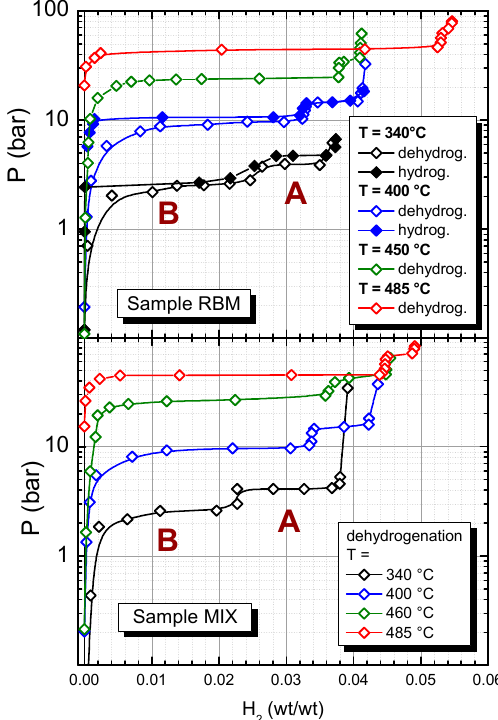
Figure 1. Pressure-composition isotherms of Sample RBM and Sample MIX at various temperatures.